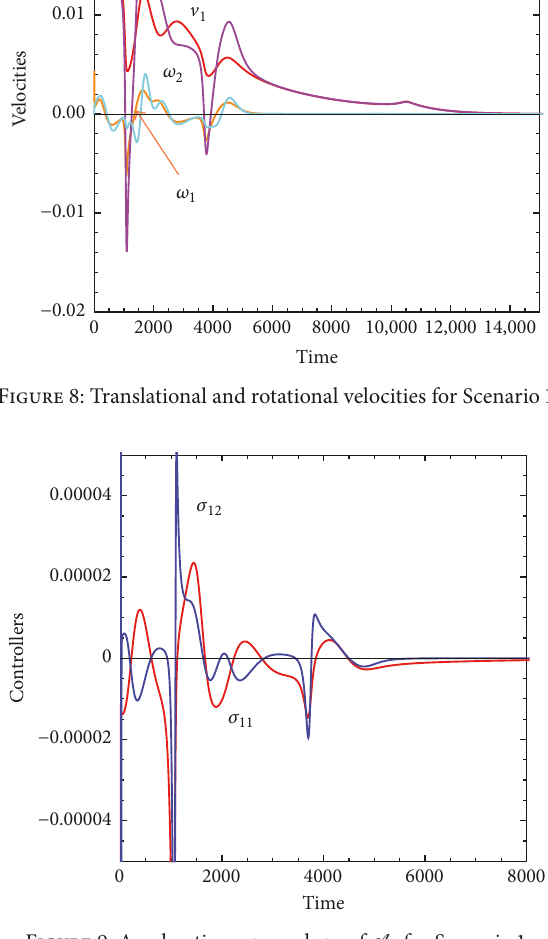
Figure 9: Accelerations 𝜎 11 and 𝜎 12 of A 1 for Scenario